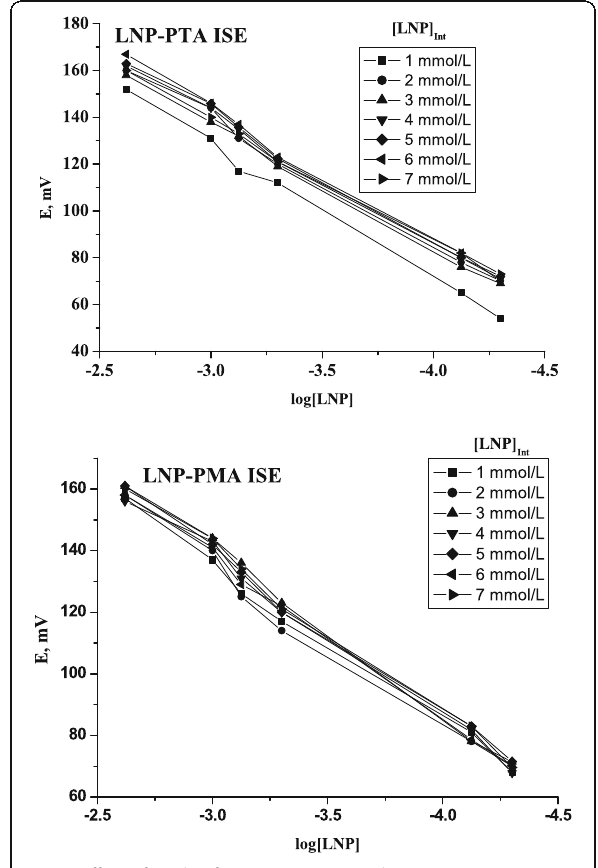
Fig. 4 Effect of study of [LNP] Int on